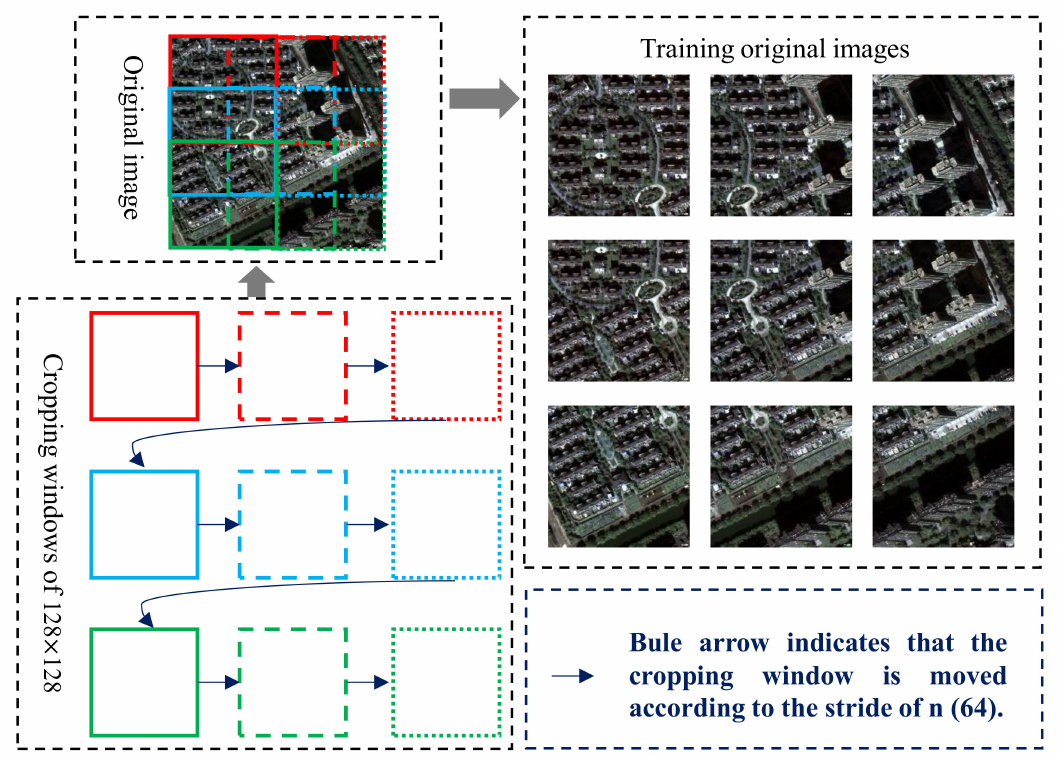
Figure 2. The overlapping cropping method for training the deep learning (DL) network. The size of the cropping windows is set to 128 × 128 pixels, where n is defined as half of